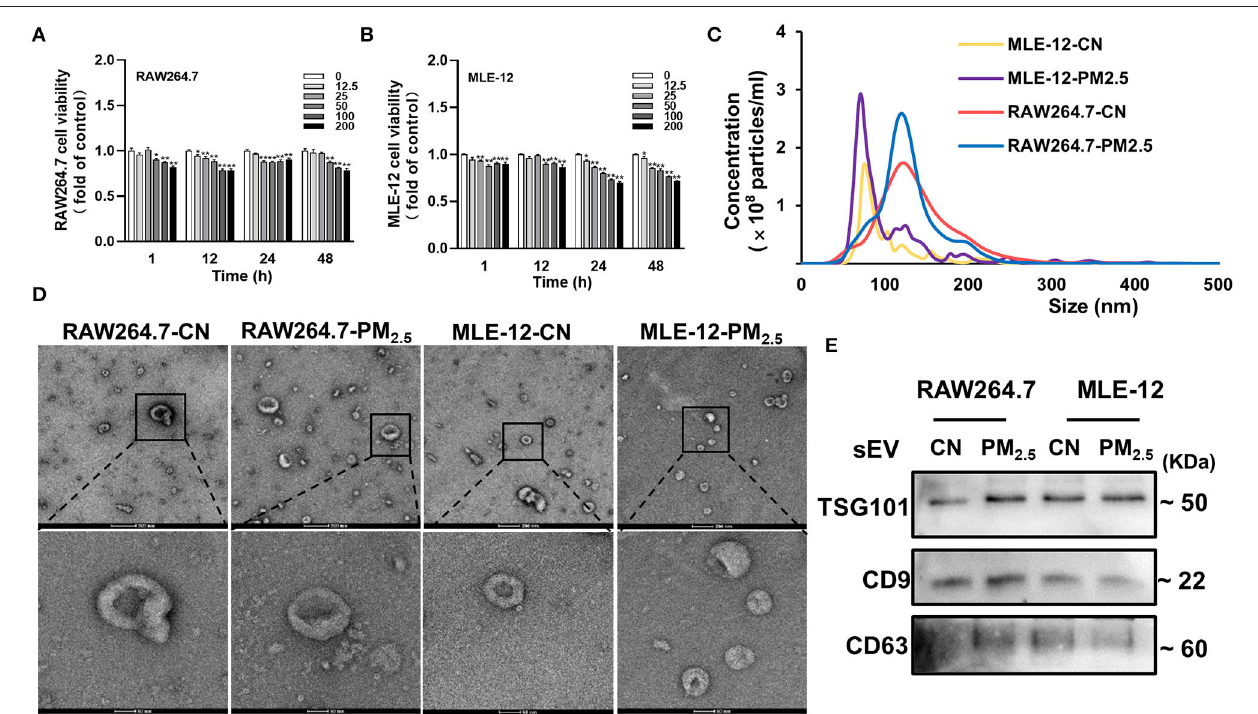
FIGURE 4 | Separation and characterization of sEV from RAW264.7 and MLE-12 after PM 2.5 exposure. (A,B) Cell viability analyzed by MTT assay. The RAW264.7 and MLE-12 were treated with various concentrations of PM 2.5 for 1, 12, 24, and 48h ( n = 5). (C) The results of NTA demonstrated the concentration and distribution in CN-sEV and PM 2.5 -sEV. (D) Representative TEM images of isolated sEV, scale bars: 200nm, 50nm. (E) Representative images of Western blot in sEV marker Alix, CD9 and CD63 in CN-sEV and PM 2.5 -sEV. All the data were presented as mean ± SEM ( t -test), n = 3–4, *indicates p < 0.05, **indicates p <